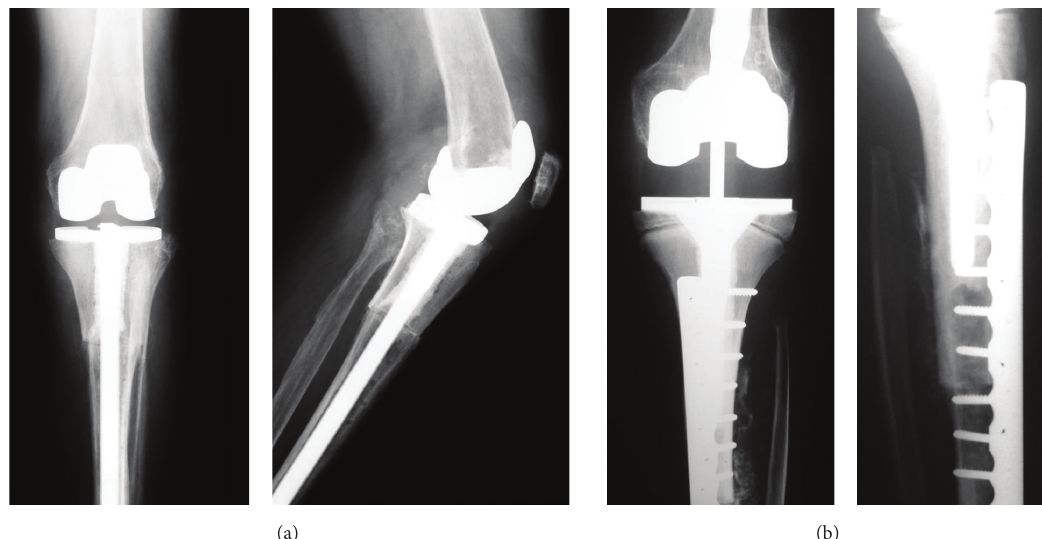
Figure 2: Reconstructions performed for proximal tibia in Group 1. (a) Proximal tibia APC with a long stem. (b) Proximal tibia APC with a short stem.